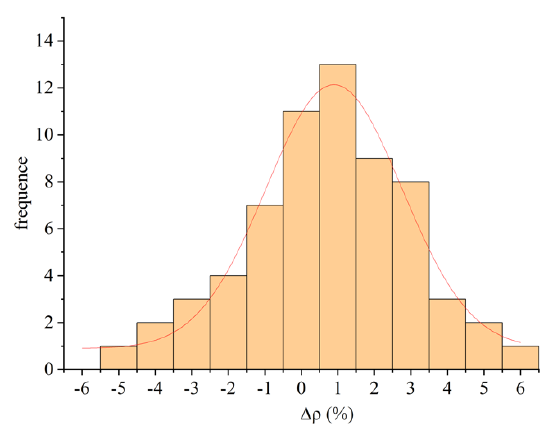
Figure 7. Statistical result chart of the relative error frequency of density of M1.